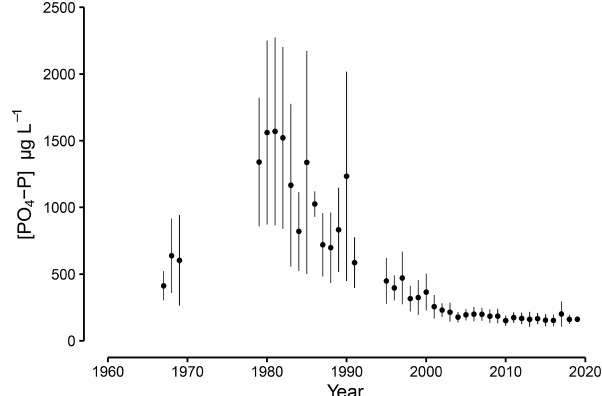
Figure 2. Concentrations of phosphate in the Scheldt River at Temse, annual means and standard deviation (error bar) around the annual mean. Samples were taken in Temse close to tidal marsh sites (data sources: ECOBE-UA and De Vlaamse Waterweg, 2016; ECOBE – UAntwerpen, 2007; Institute voor Hygiëne en